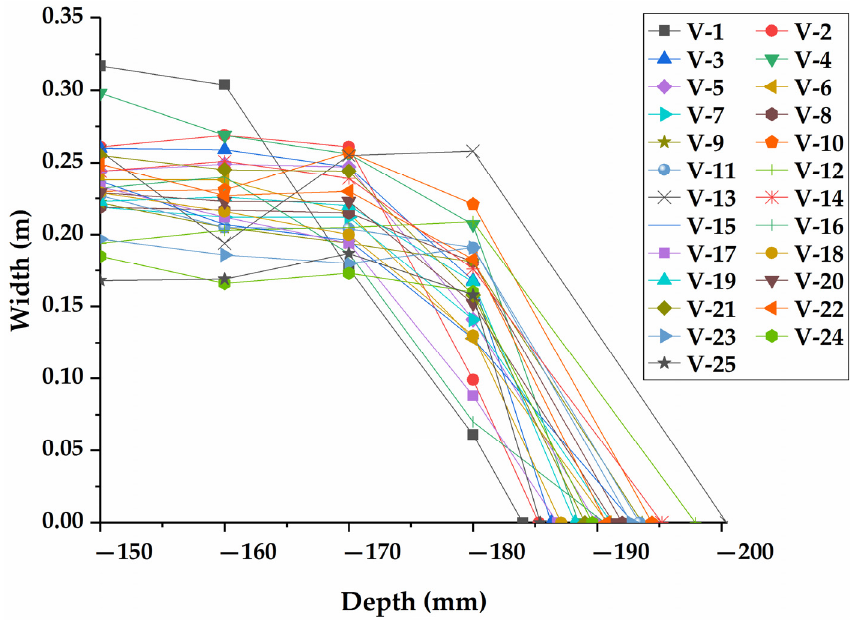
Figure 21. The width change from 150 cm to the bottom of the ground fissure on each longitudinal section.